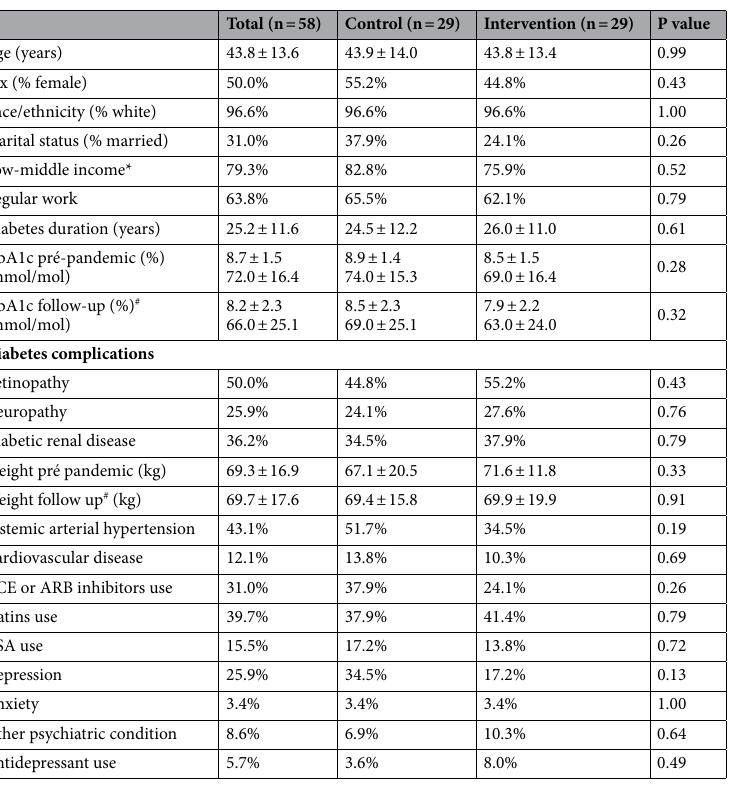
Table 1. Baseline characteristics of study participants. Data are mean ± standard deviation or %. α ≤ 0.05 indicates significant difference. HbA1c glycated hemoglobin, ACE angiotensin-converting enzyme,